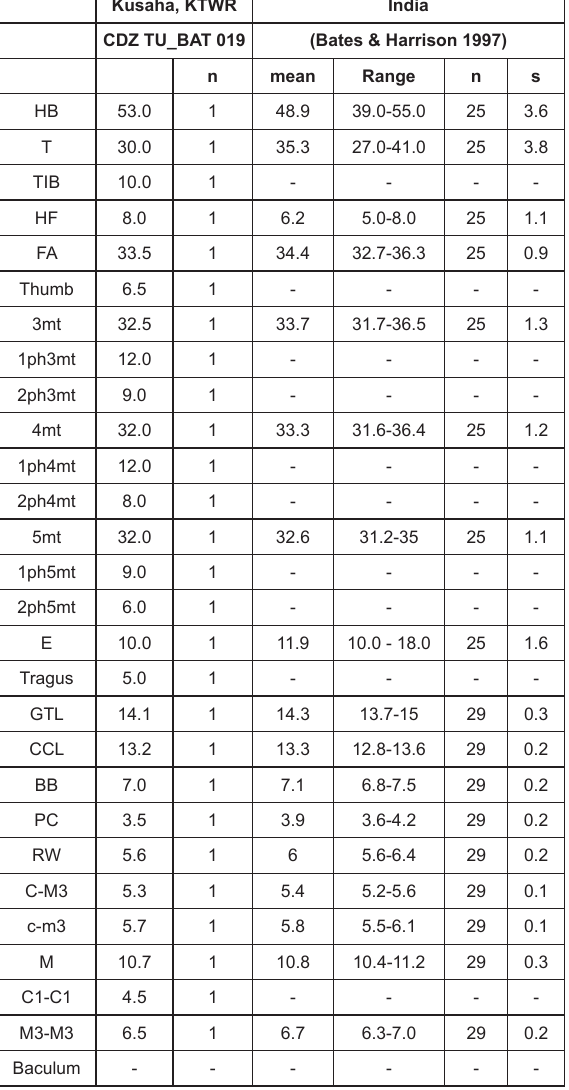
Table 1. External, cranial, and dental measurements (in mm.) of Scotozous dormeri (CDZ TU_BAT 019) from Kusaha, Koshi Tappu WR, Nepal and from